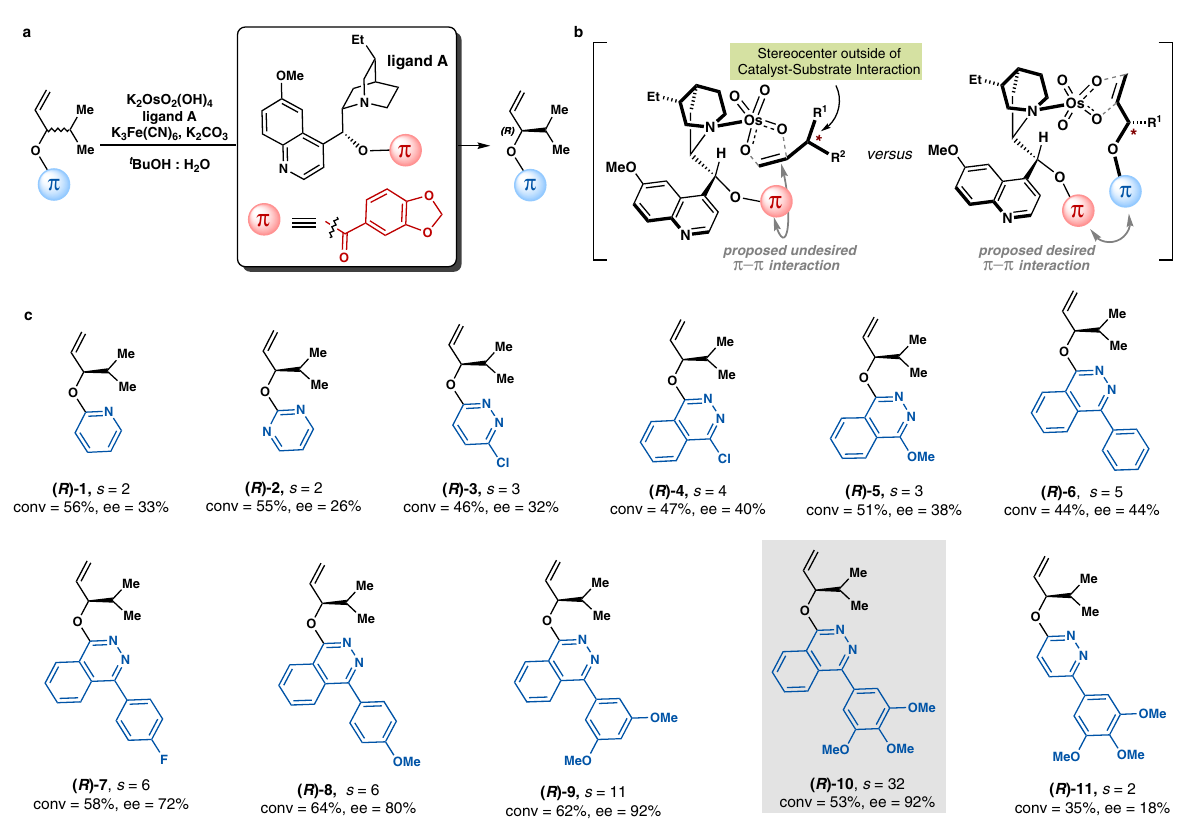
Fig. 2 Development of effective non-covalent π interactions between the catalyst and the alkene substrate for AD-based kinetic resolution. a Using cinchona alkaloid ligand A with the piperonylate moiety as a large, delocalized π system in AD-based kinetic resolution. b Proposed possible π – π interactions in the racemic alkene substrates/Ligand A -OsO 4 complexes. c Screening an appropriate π moiety in the alkene substrate that could establish desired π – π interactions with the piperonylate moiety in ligand A . General condition: K 2 OsO 2 (OH) 4 (0.4 mol%), K 3 Fe(CN) 6 (3.0 equiv), K 2 CO 3 (3.0 equiv), ligand A (1.0 mol%) and alkene (0.1 mmol) in 1.0 mL t BuOH-H 2 O ( v / v = 1:1), 0 °C. s : selectivity factor; s = In[(1 − c)(1 − ee)]/In[(1 − c)(1 + ee)]. Conversion (conv) was determined by 1 H NMR analysis of the crude